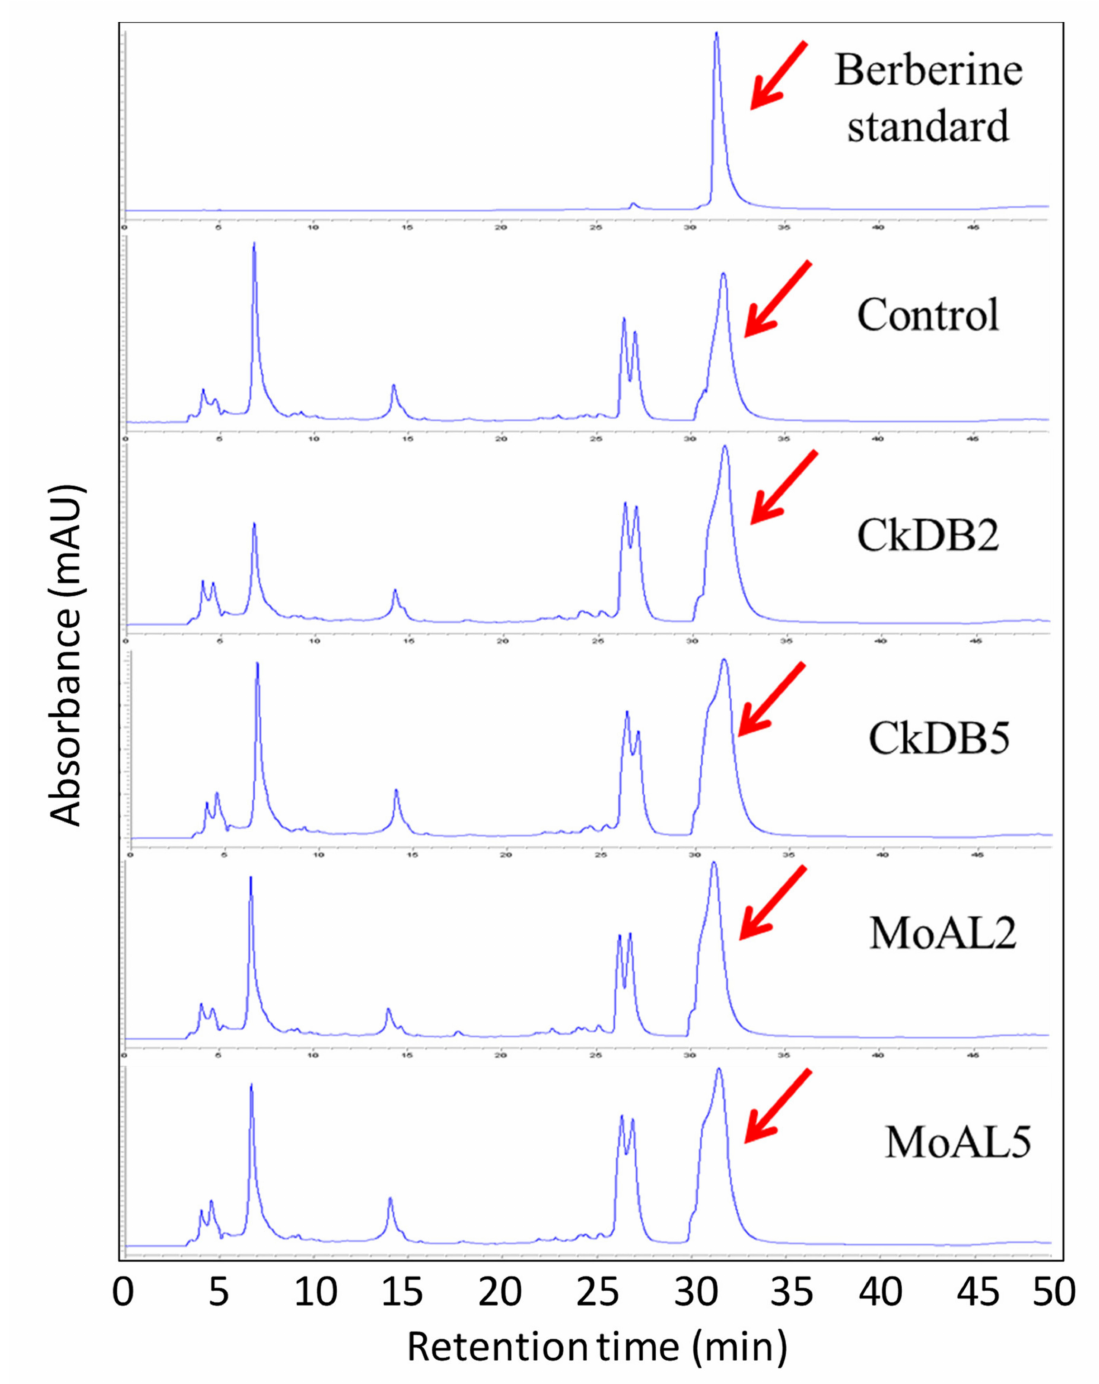
Figure 3. The high-performance liquid chromatography evaluation of berberine production after culture of M. oiwakensis seedlings for 3 months in either inoculated or control